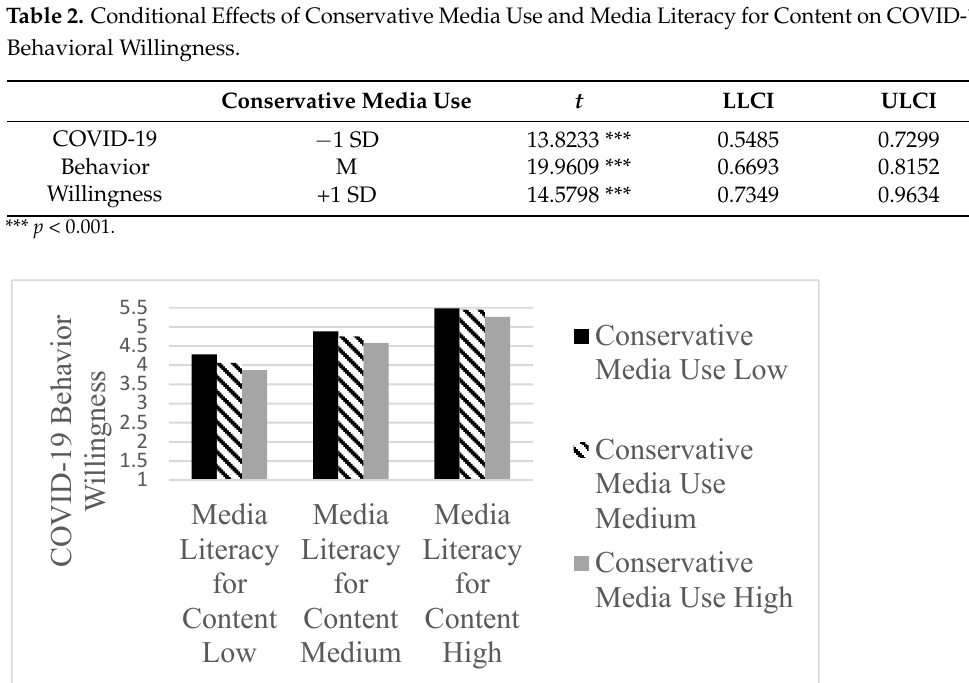
Figure 2. Interaction effects between Conservative Media use and Media Literacy for Source on COVID-19 Behavior Willingness.